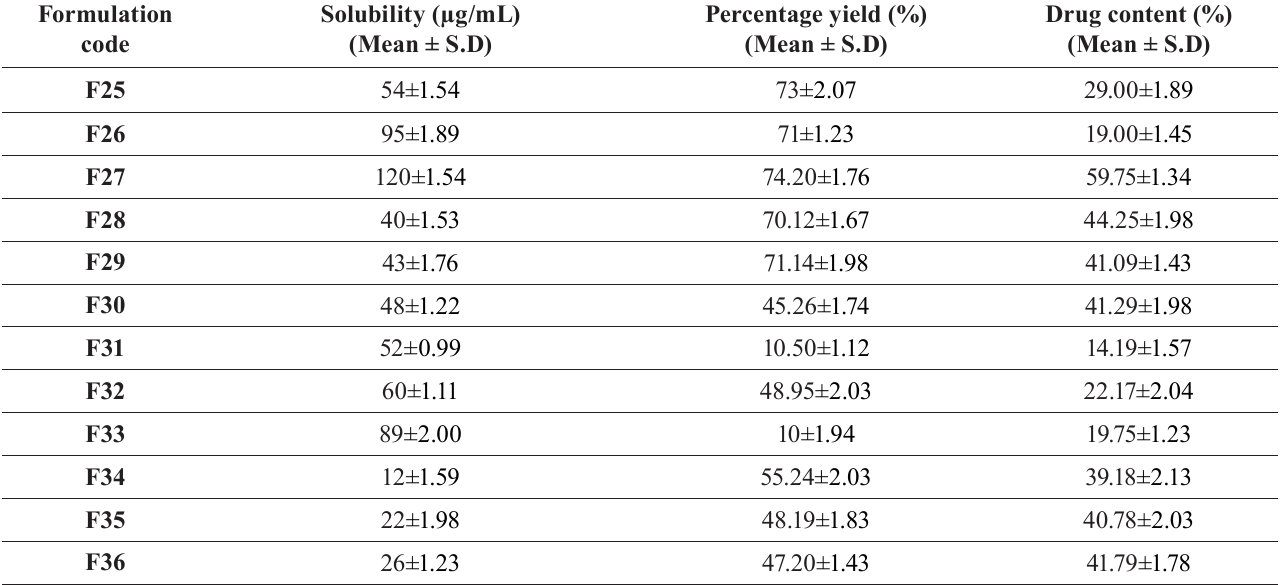
TABLE V - S olubility (µg/ml), percentage yield (%), and drug content (%) data of selected inclusion complexes